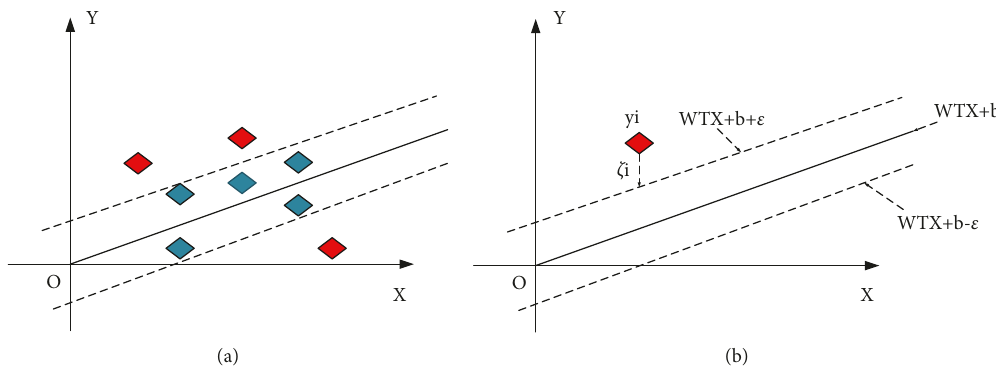
Figure 5: SVR algorithm schematic diagram. (a) SVR schematic diagram and (b) function expression diagram.